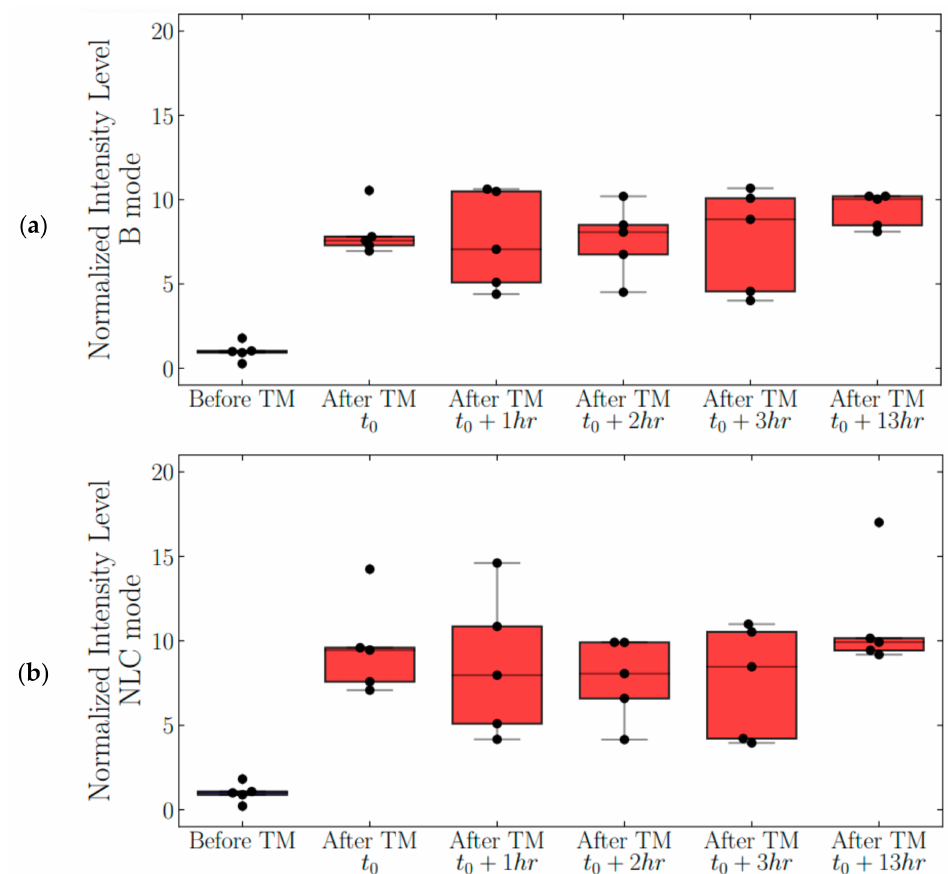
Figure 4. Analysis of nanodroplet stability. ( a ) Ultrasound signal intensity on the B-mode as a function of time for a 13 h period ( n = 5). ( b ) Ultrasound signal intensity on the NLC mode as a function of time for 13 h ( n =